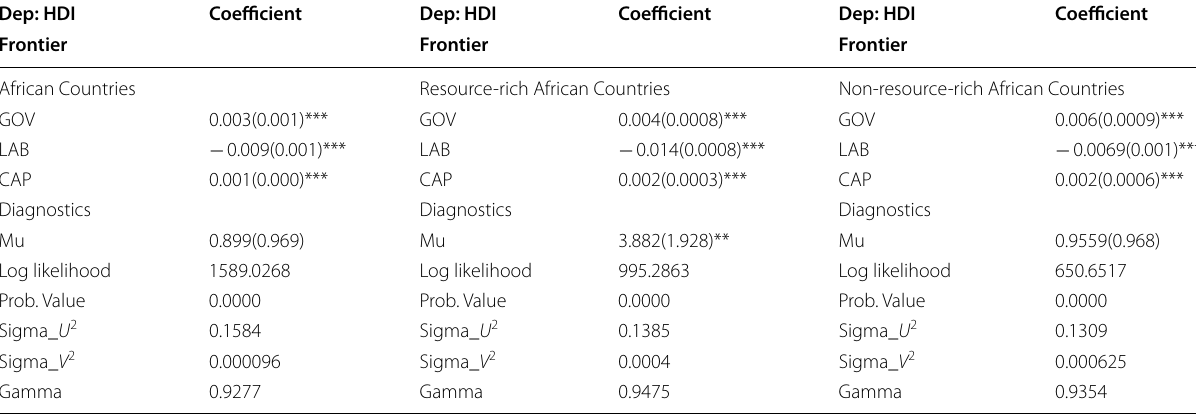
Table 7 Frontier model for government efficiency. Source Authors Computation (2022)